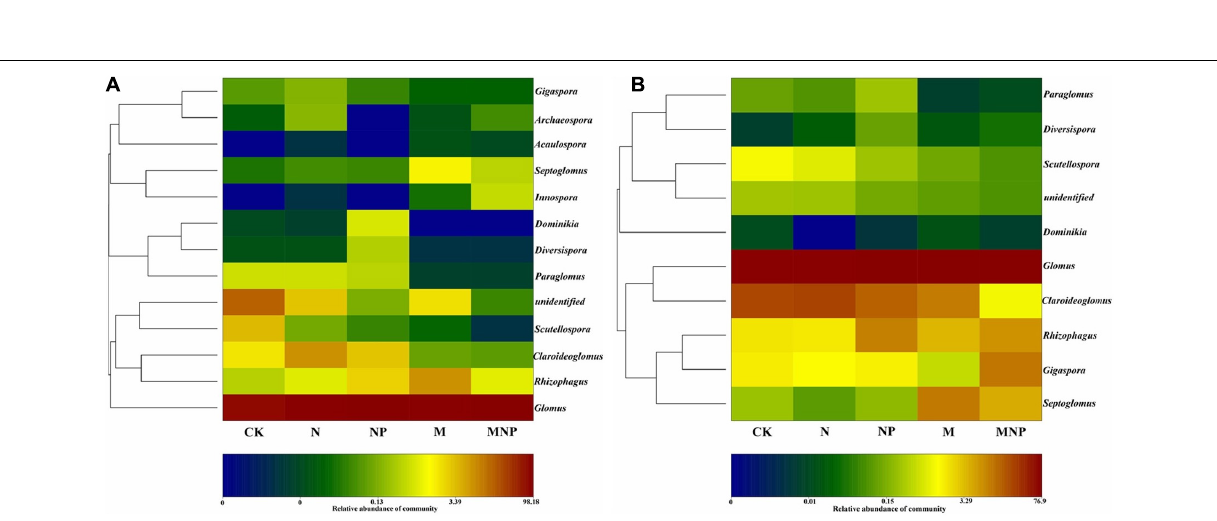
Frontiers in Microbiology |